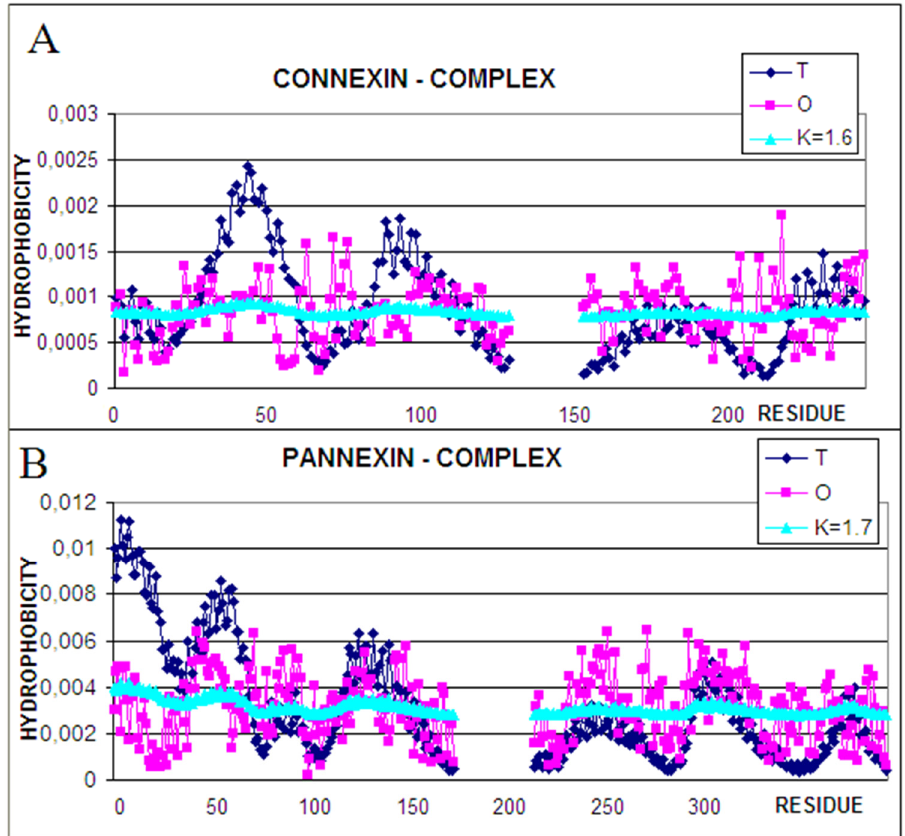
Figure 3. Profiles for the distribution of T (navy), O (pink), and M (turquoise)for K values as shown in the legend: ( A )—6L3T—connexin, ( B )—7F8J—pannexin. Despite the lower number of ligands in connexin, the status of interacting residues with them is expressed by a higher RD value, which means a higher influence on the status related to the external environment.